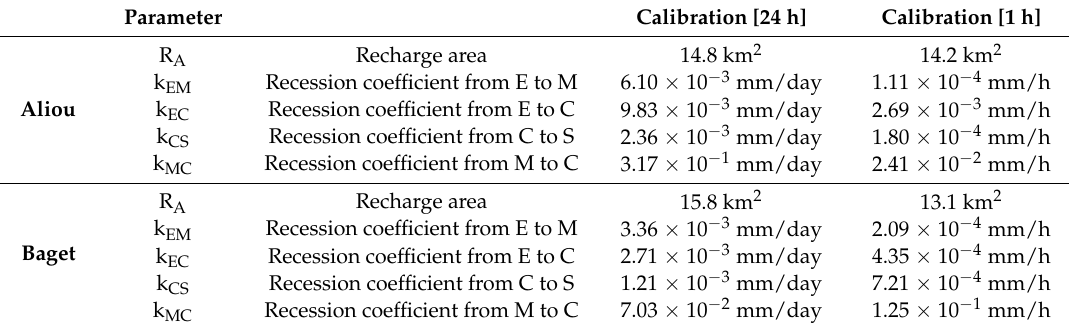
Table 2. Calibration values of the model parameters for Aliou and Baget watersheds.